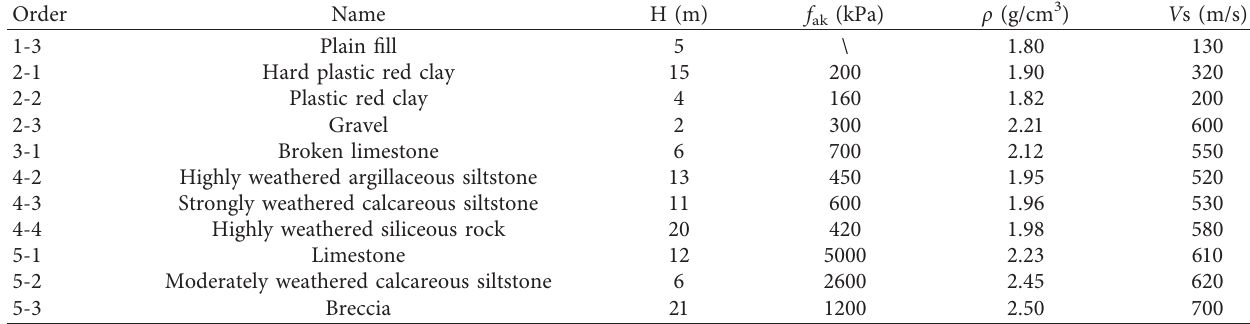
Table 1: Soil parameters of a project in Nanning area.